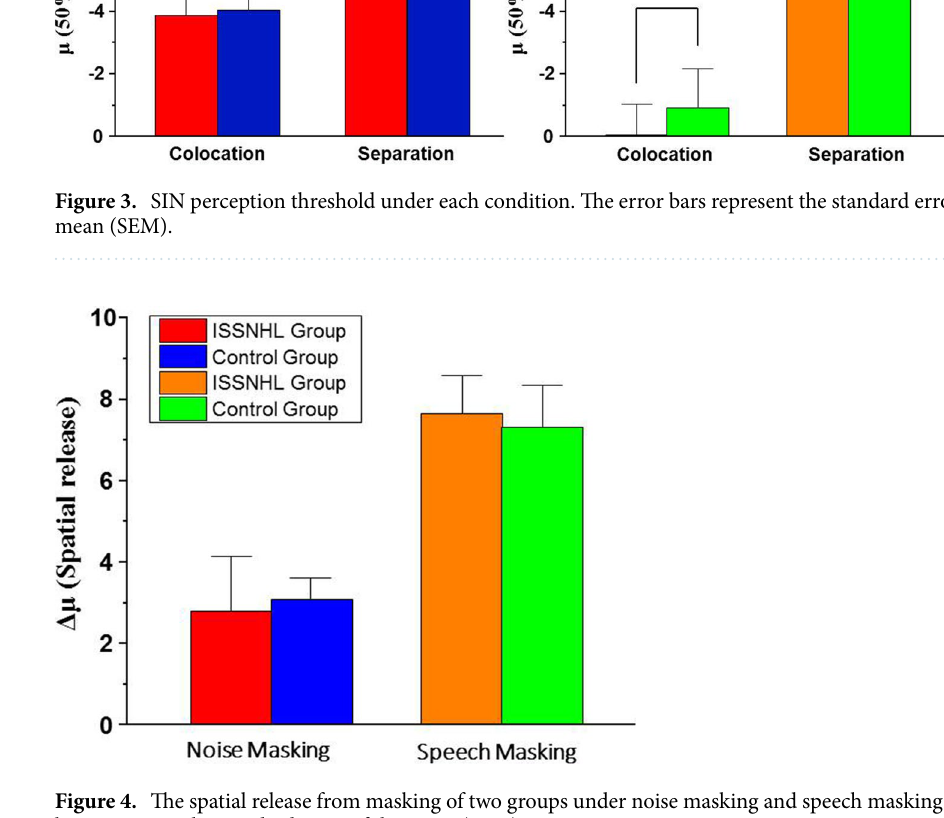
Figure 4. The spatial release from masking of two groups under noise masking and speech masking. The error bars represent the standard error of the mean